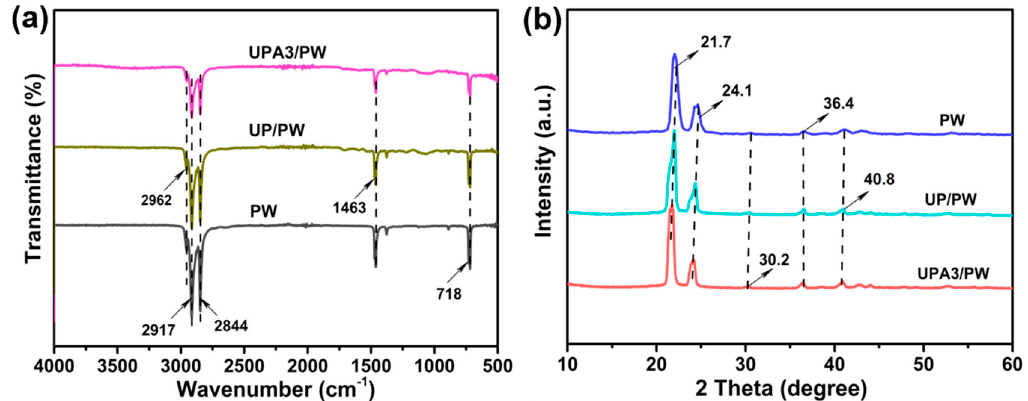
Figure 2. ( a ) FT–IR spectra and ( b ) XRD patterns of PW, UP/PW and